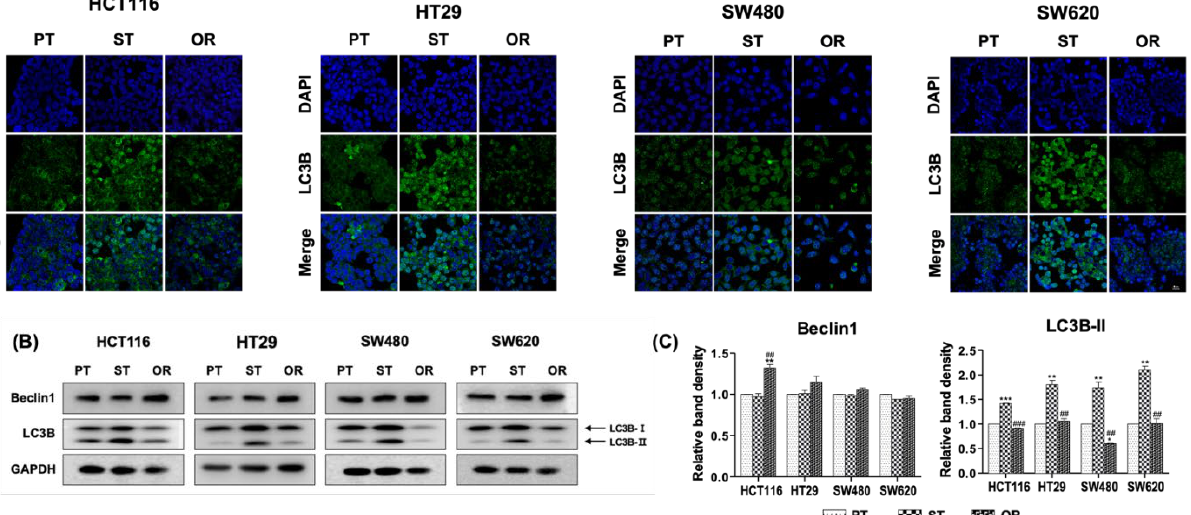
Figure 4. Effects of oxaliplatin resistance on the induction of autophagy in the parental (PT), 2.5 µM oxaliplatin single treated PT for 24 h (ST) and oxaliplatin-resistant (OR) colorectal cancer (CRC) cells of HCT116, HT29, SW480 and SW620. ( A ) LC3B was visualized by immunofluorescence using confocal microscopy. LC3B protein was labeled green (Alexa 488) and the nucleus was stained with DAPI. The size of scale bar was 20 µm. ( B ) Protein expression of Beclin-1 and LC3B was determined by immunoblot analysis. ( C ) Graphical analysis of band intensities normalized for protein loading with GAPDH. Columns and error bars represent means ± standards deviation of immunoblot band intensities of 3 separate protein preparations. The * statistics showed the comparison with PT and the # statistics showed the comparison between ST and OR. * p < 0.05; ** or ## , p < 0.01; *** or ### , p < 0.001. GAPDH, glyceraldehyde 3-phosphate dehydrogenase.